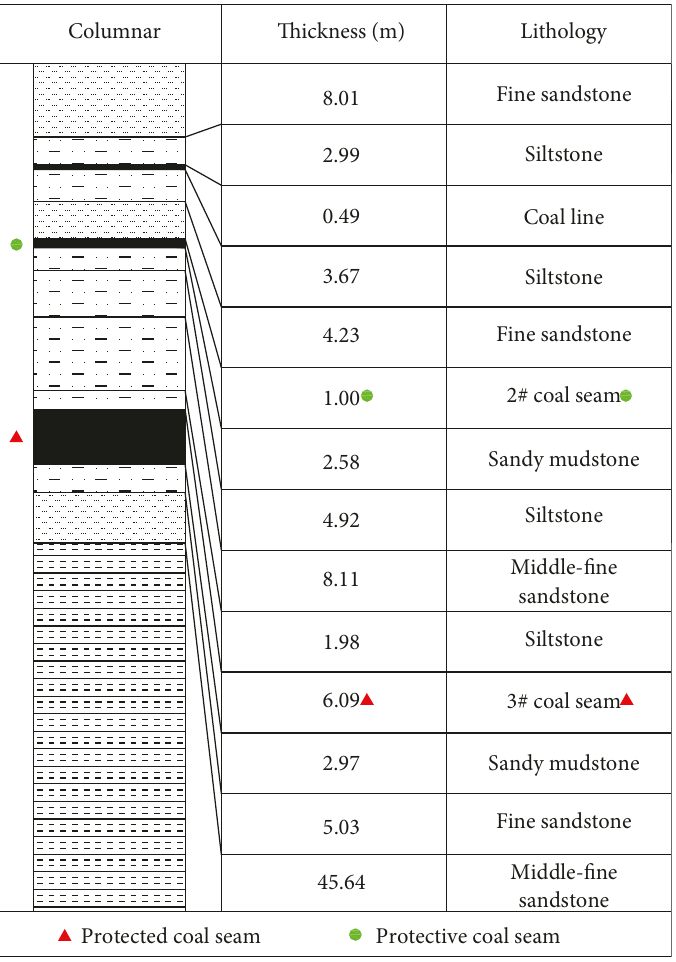
Figure 4: Borehole diagram of the working face.